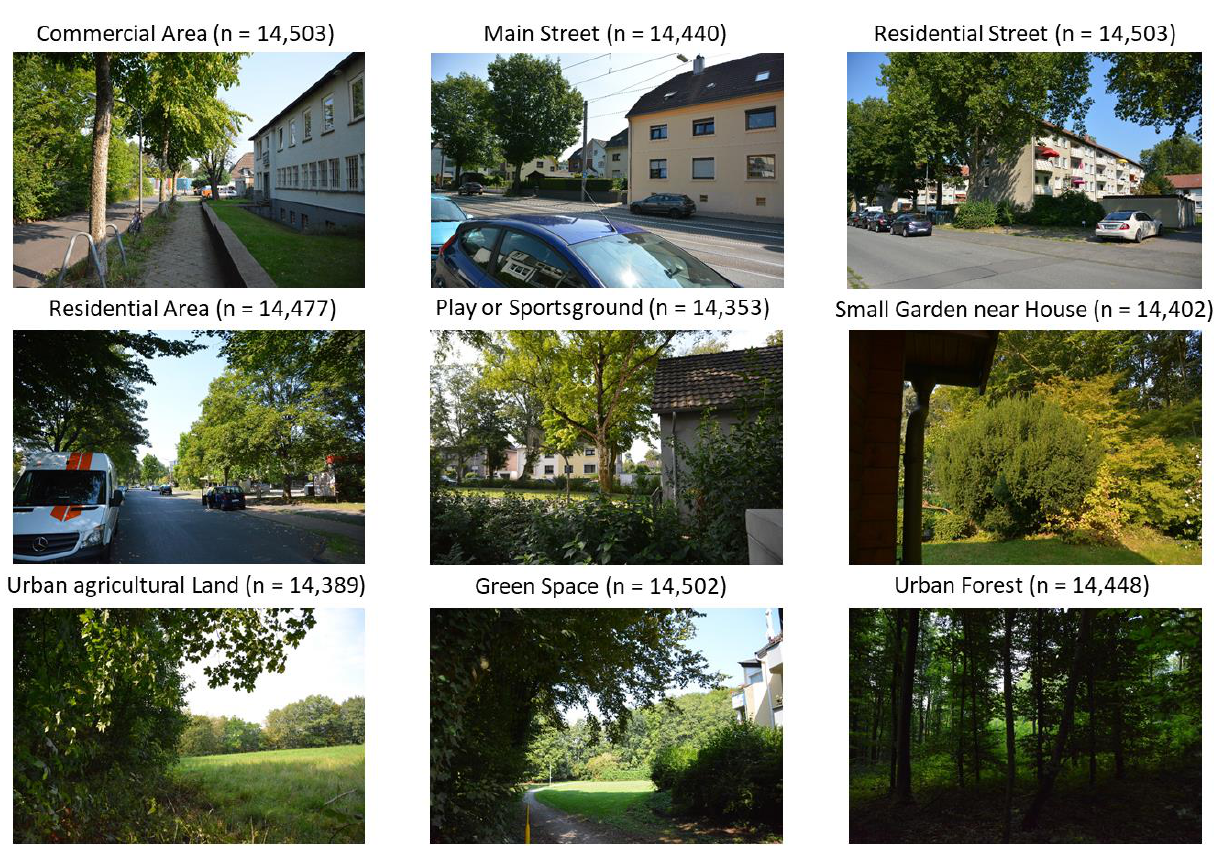
Figure 1. Pictures and classification of the urban environment around all nine recording devices. The number in brackets is the number of 3-min recordings per site. In total, 130,017 recordings were used for this work.